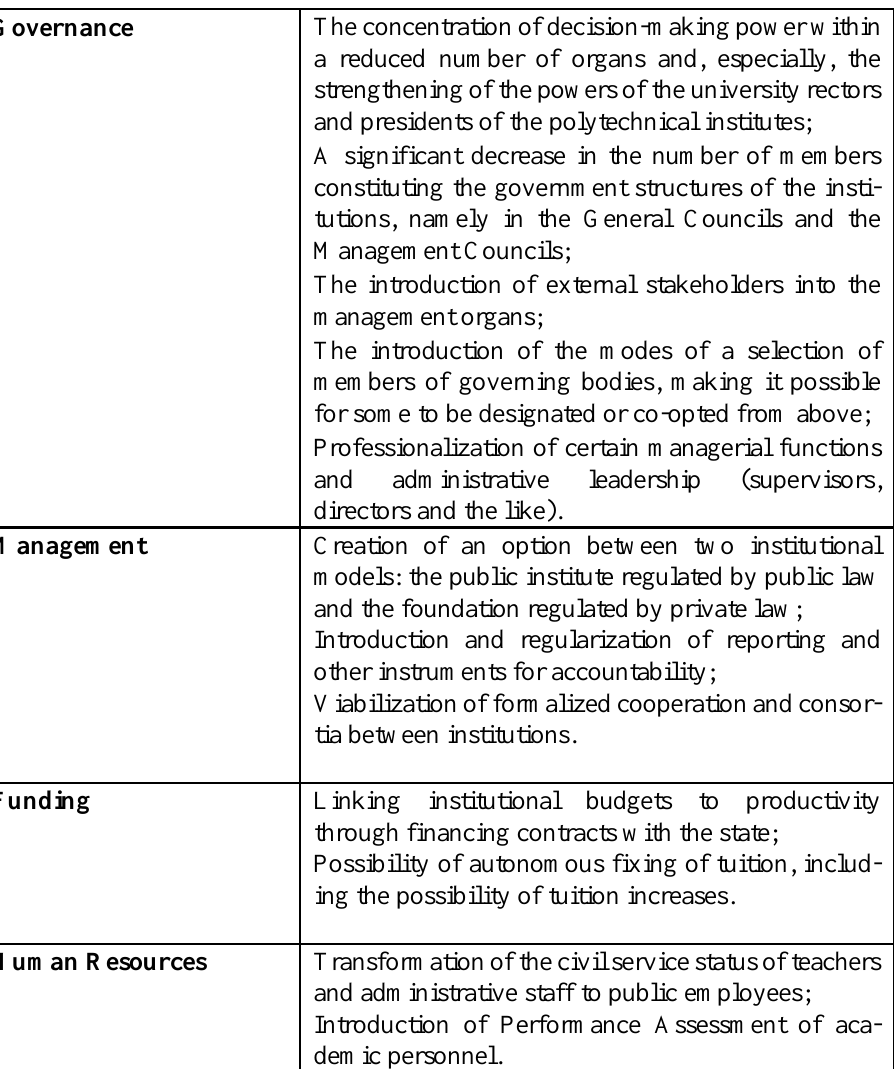
Table 2 Main changes introduced by RJIES